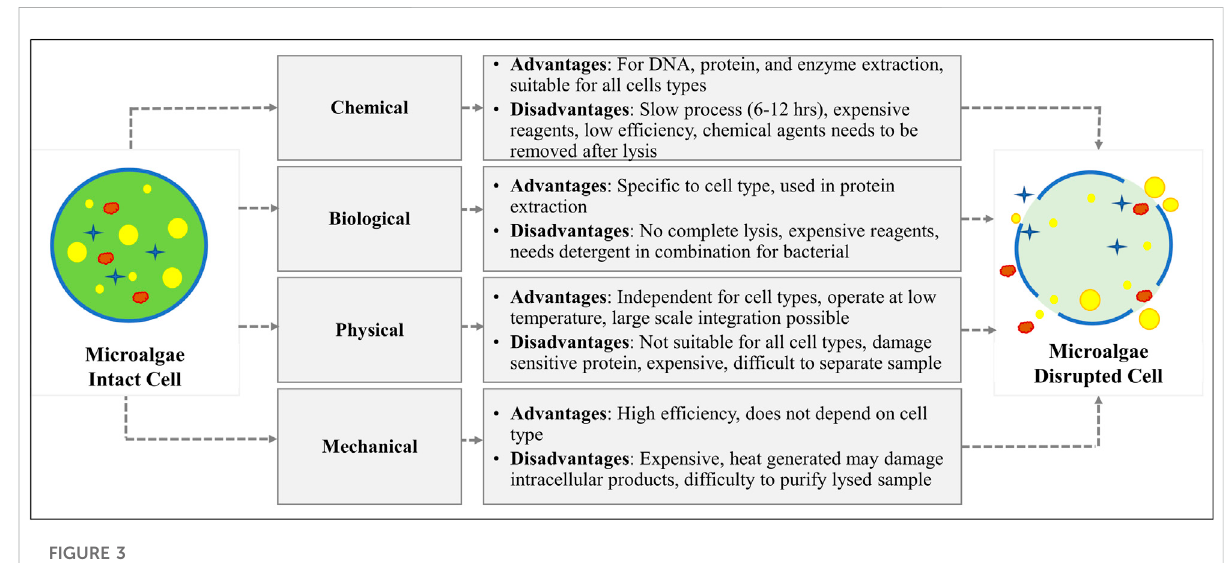
FIGURE 3 Advantages and disadvantages of different cell disruption